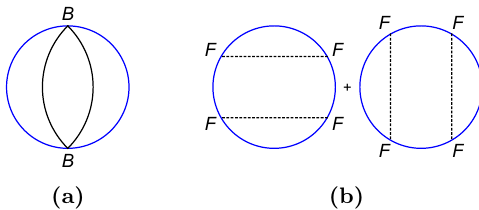
Figure 7. Two-loop Feynman diagrams for h Tr P (e (cid:0) i H d(cid:28)L bos ( (cid:28) ) W 4 ) i f